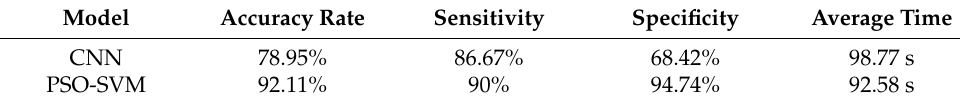
Table 8. Classification results of the test set on different models.